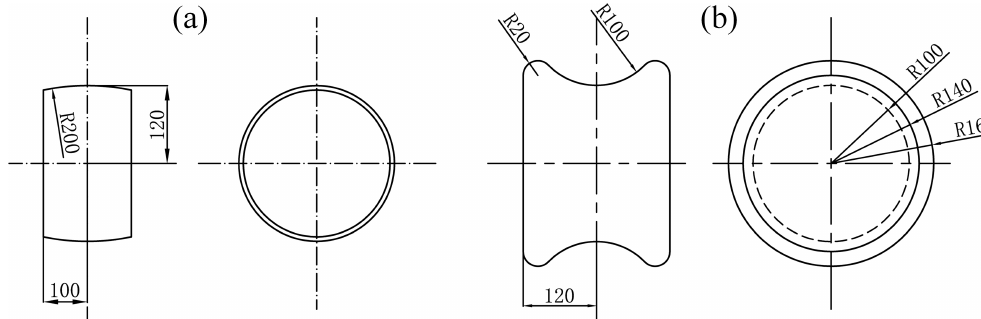
Figure 3. Shape and dimensions of upper/lower roller (unit: mm). (a) Upper Roller. (b) Lower Roller.